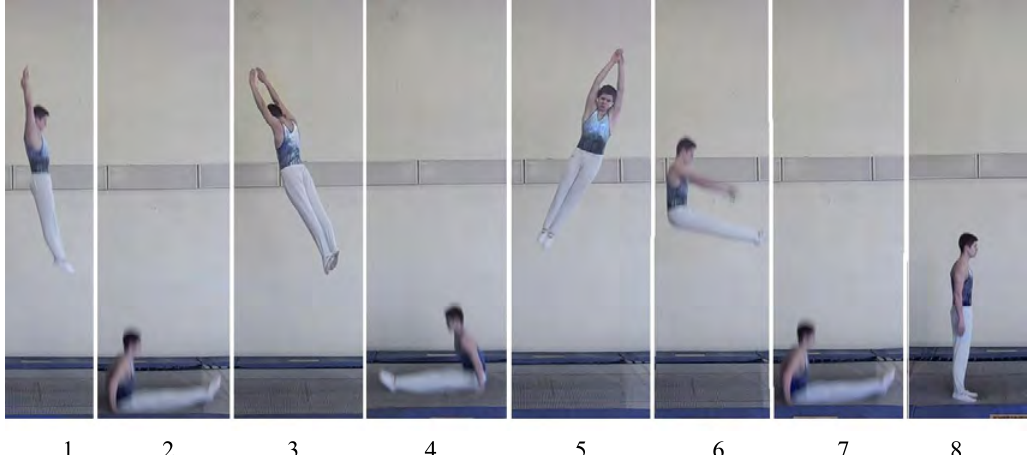
Fig.15. Combination 3. Temp jump (shot 1) and landing in sitting position (shot 2); jump upward with left turn by 180° andlanding in sitting position (shots 3 – 4); jump upward with right turn by 180° and landing in sitting position (shots 5 – 7); stoppage (shot 8).